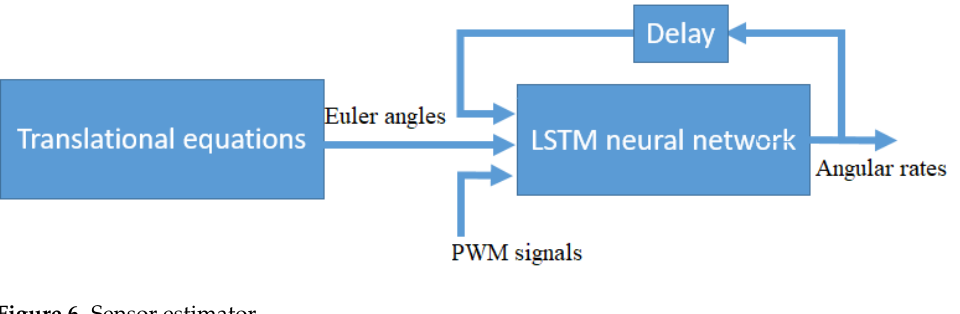
Figure 6. Sensor